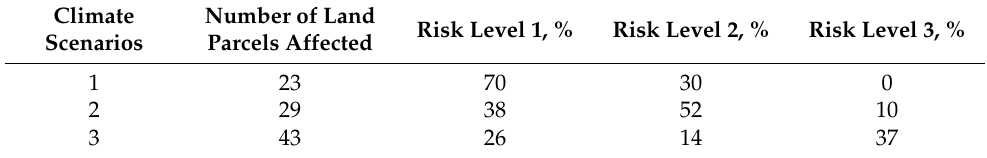
Table 3. Number of related properties and their risk levels for scenarios 1, 2 and 3 in